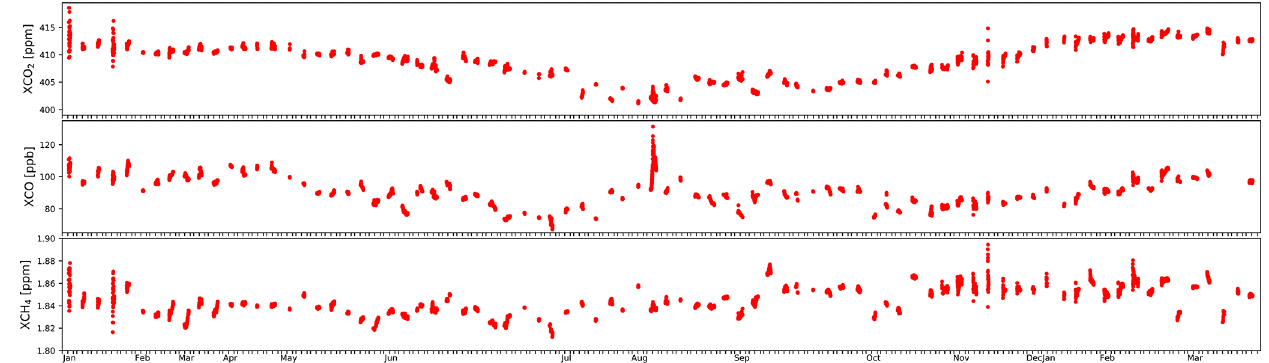
Figure 5. Time series for XCO 2 , XCO and XCH 4 obtained in Peterhof during the continuous campaign.